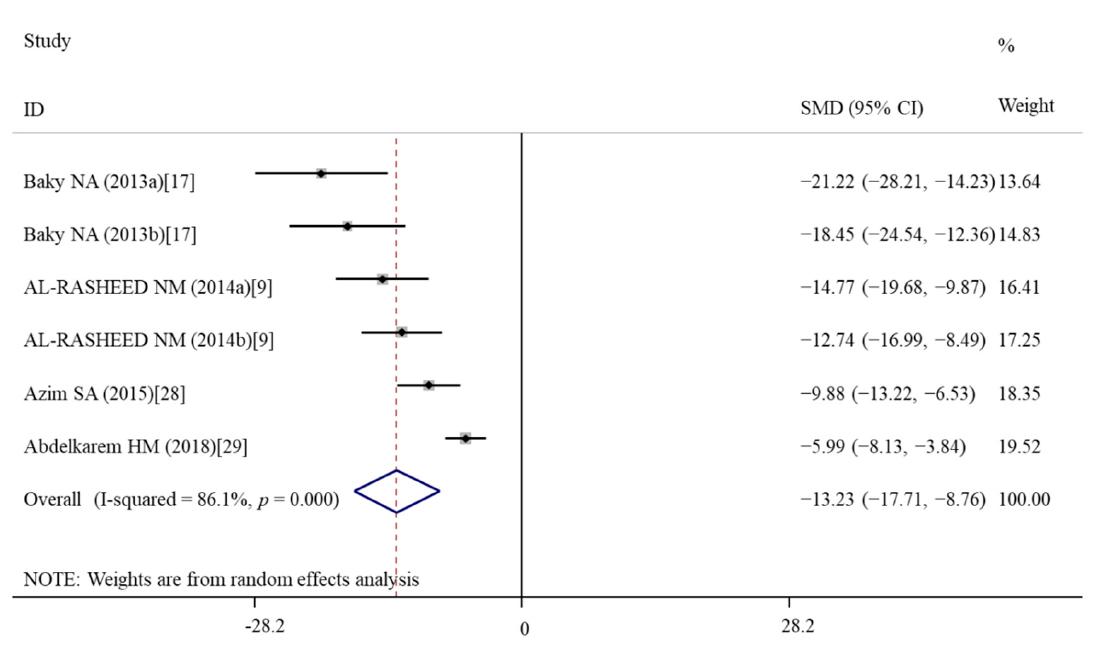
Figure 6. Forest plots showing the protective effects of vitamin E on TNF- α levels of murine models compared with the nanomaterial exposure group. a, b of the study of Baky et al. and AL-RASHEED et al. represent treatment with 600 and 1000 mg/kg of ZnONPs. TNF, tumor necrosis factor; SMD, standardized mean difference; CI, confidence interval [8,9,17,28,29].